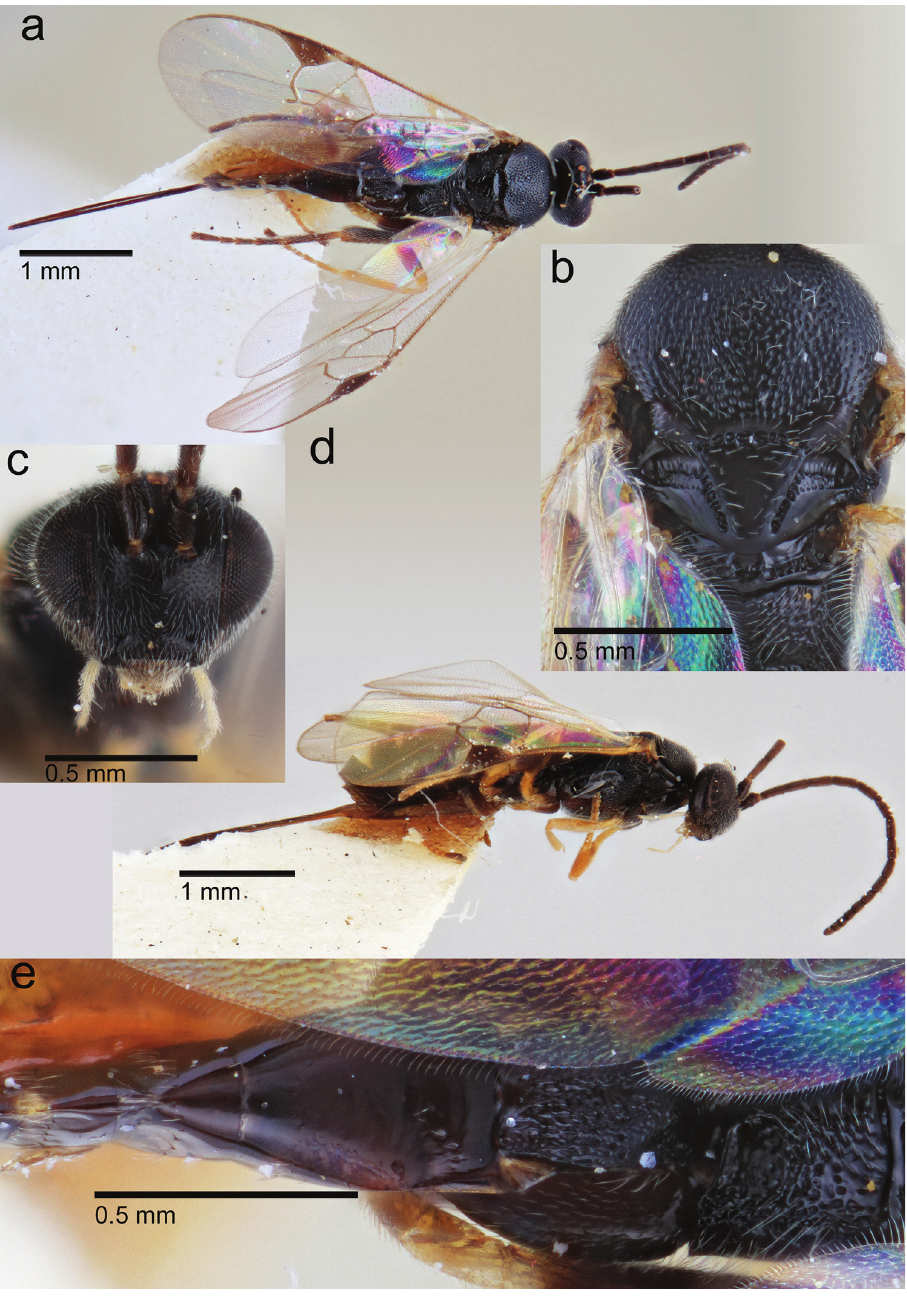
Figure 3. Dolichogenidea mediocaudata (holotype): a dorsal habitus b anteromesoscutum, mesoscutel- lum and metanotum c head d lateral habitus e propodeum and